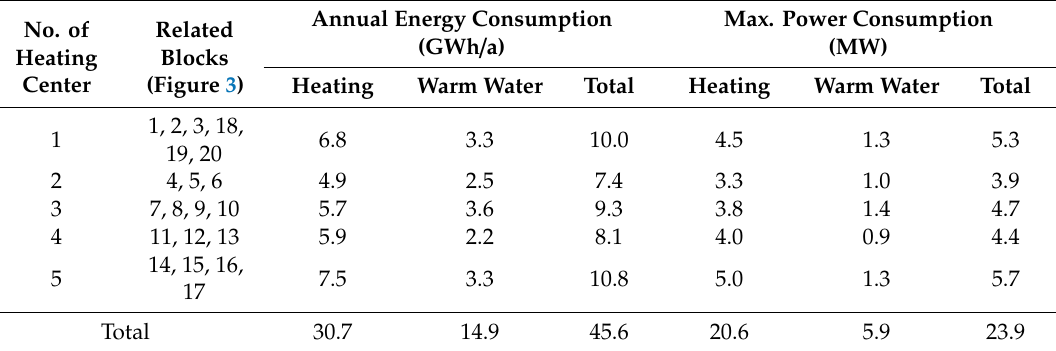
Table 6. Heating centers and attached blocks as well as energy and power consumption per heating center.